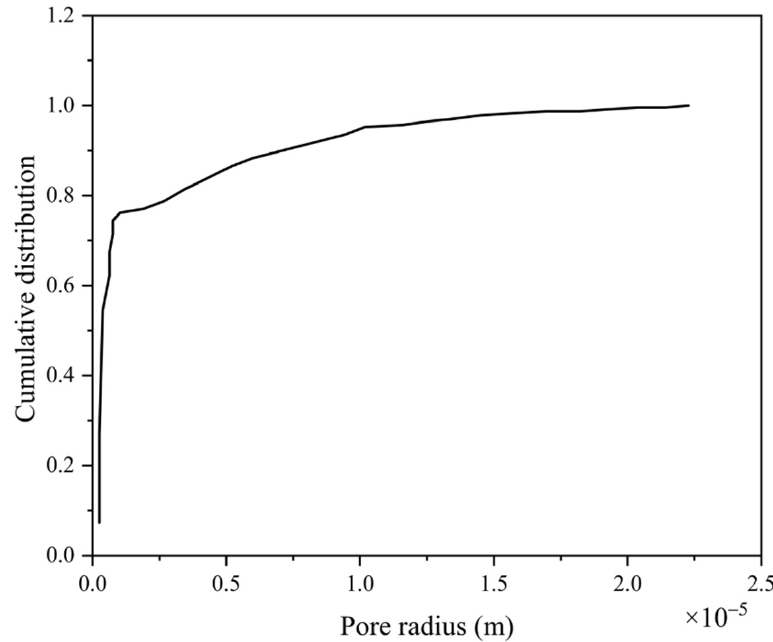
Figure 4. Cumulative probability distribution of pore